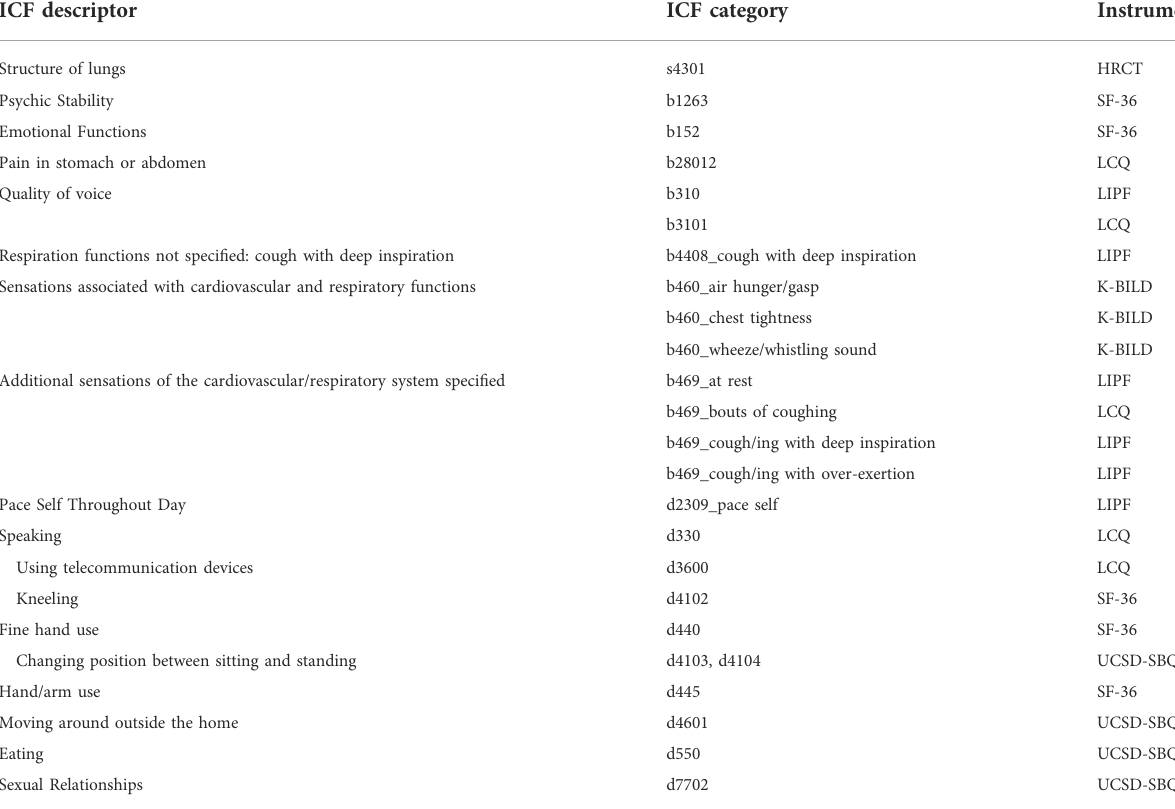
TABLE 5 Categorical concepts unique to a single instrument ( Courtesy LA Saketkoo, with permission, rights reserved.